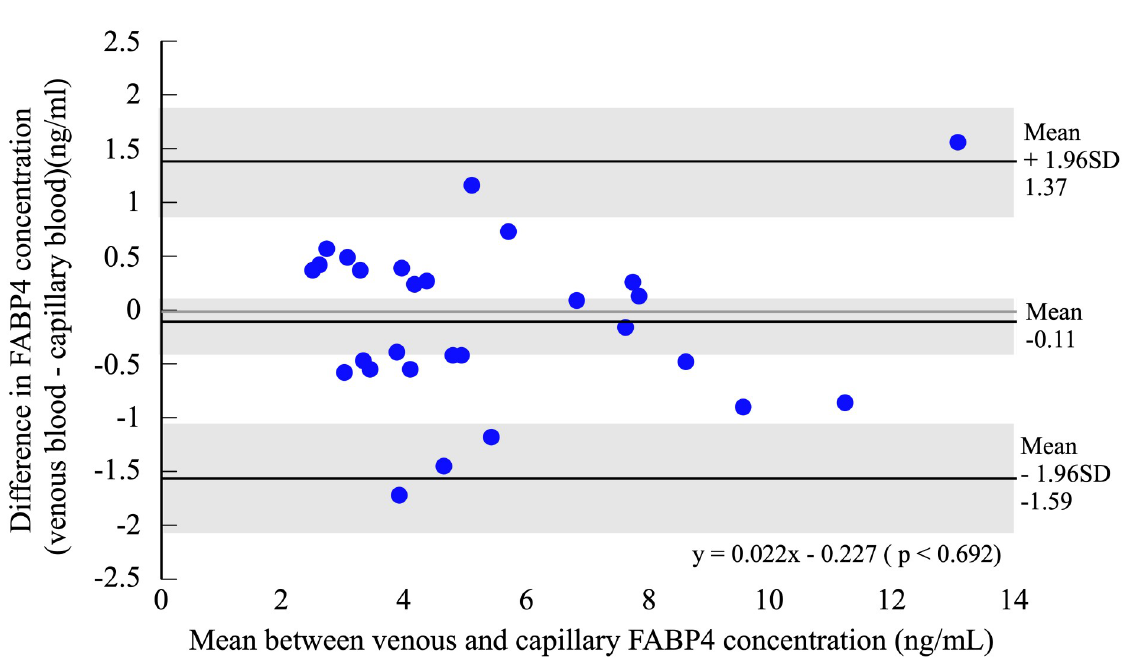
Fig 3. Bland and Altman plots showing the difference against the average plasma FABP4 concentrations between venous and capillary blood. Solid lines represent the mean bias and the 95% limits of agreement. Shadows are confidence intervals. There was no correlation between the difference and average plasma FABP4 concentrations between venous and capillary